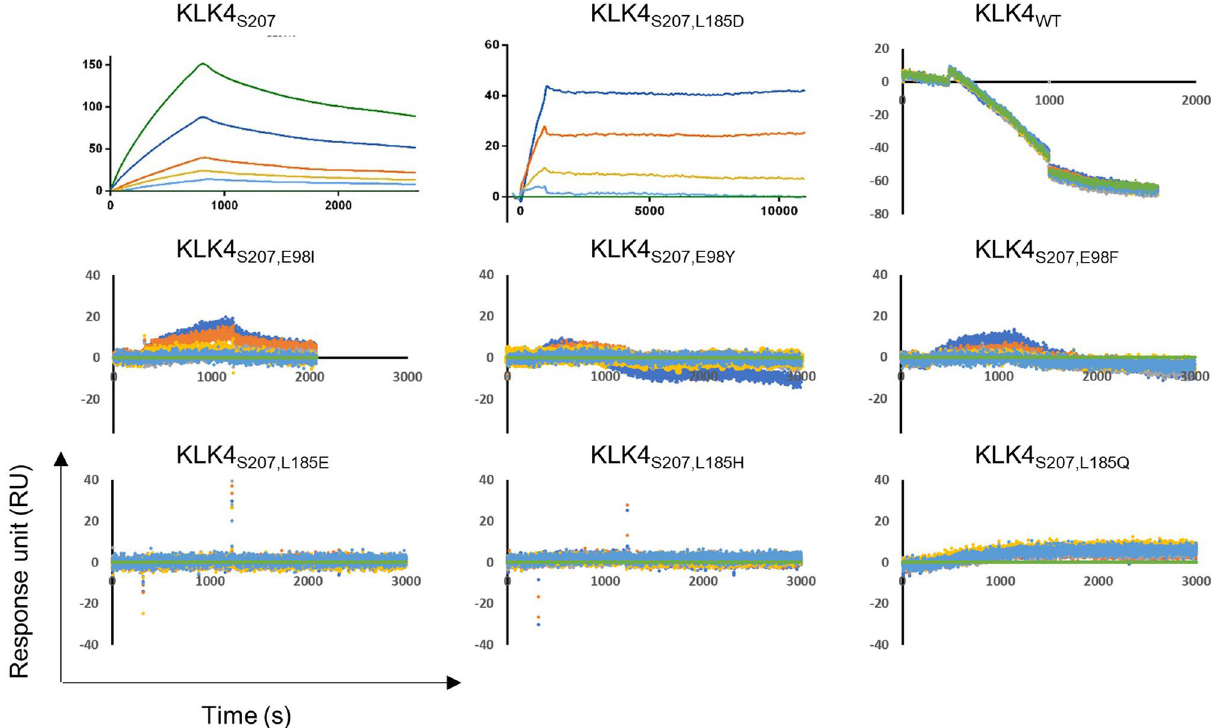
Figure 2. SPR sensorgrams of the binding interactions between a biotinylated PAR1 peptide, immobilized on a ProteOn NLC chip, and soluble KLK4 S207A (0.125–2 µM), KLK4 S207A,L185D (0.5–8 µM), KLK4 WT (6.25–100 nM), KLK4 S207A,E98I/Y/F (0.125–2 µM) and KLK4 S207A,L185E/H/Q (0.125–2 µM). The analyses of the association and dissociation of KLK4 variants upon addition to the chip-immobilized PAR1 were carried out for 818 s and for 30 min, respectively, except for KLK4 S207AL185D , for which the dissociation step was extended to 166